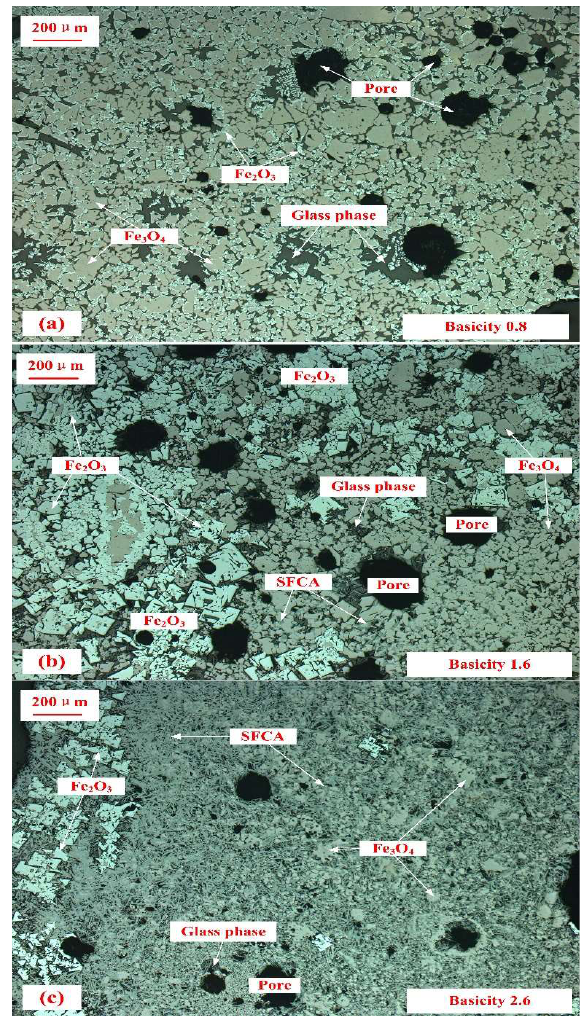
Figure 8. Microstructure of sinter with different basicity (2.35% MgO), ( a ) basicity 0.8, ( b ) basicity 1.6, ( c ) basicity 2.6.